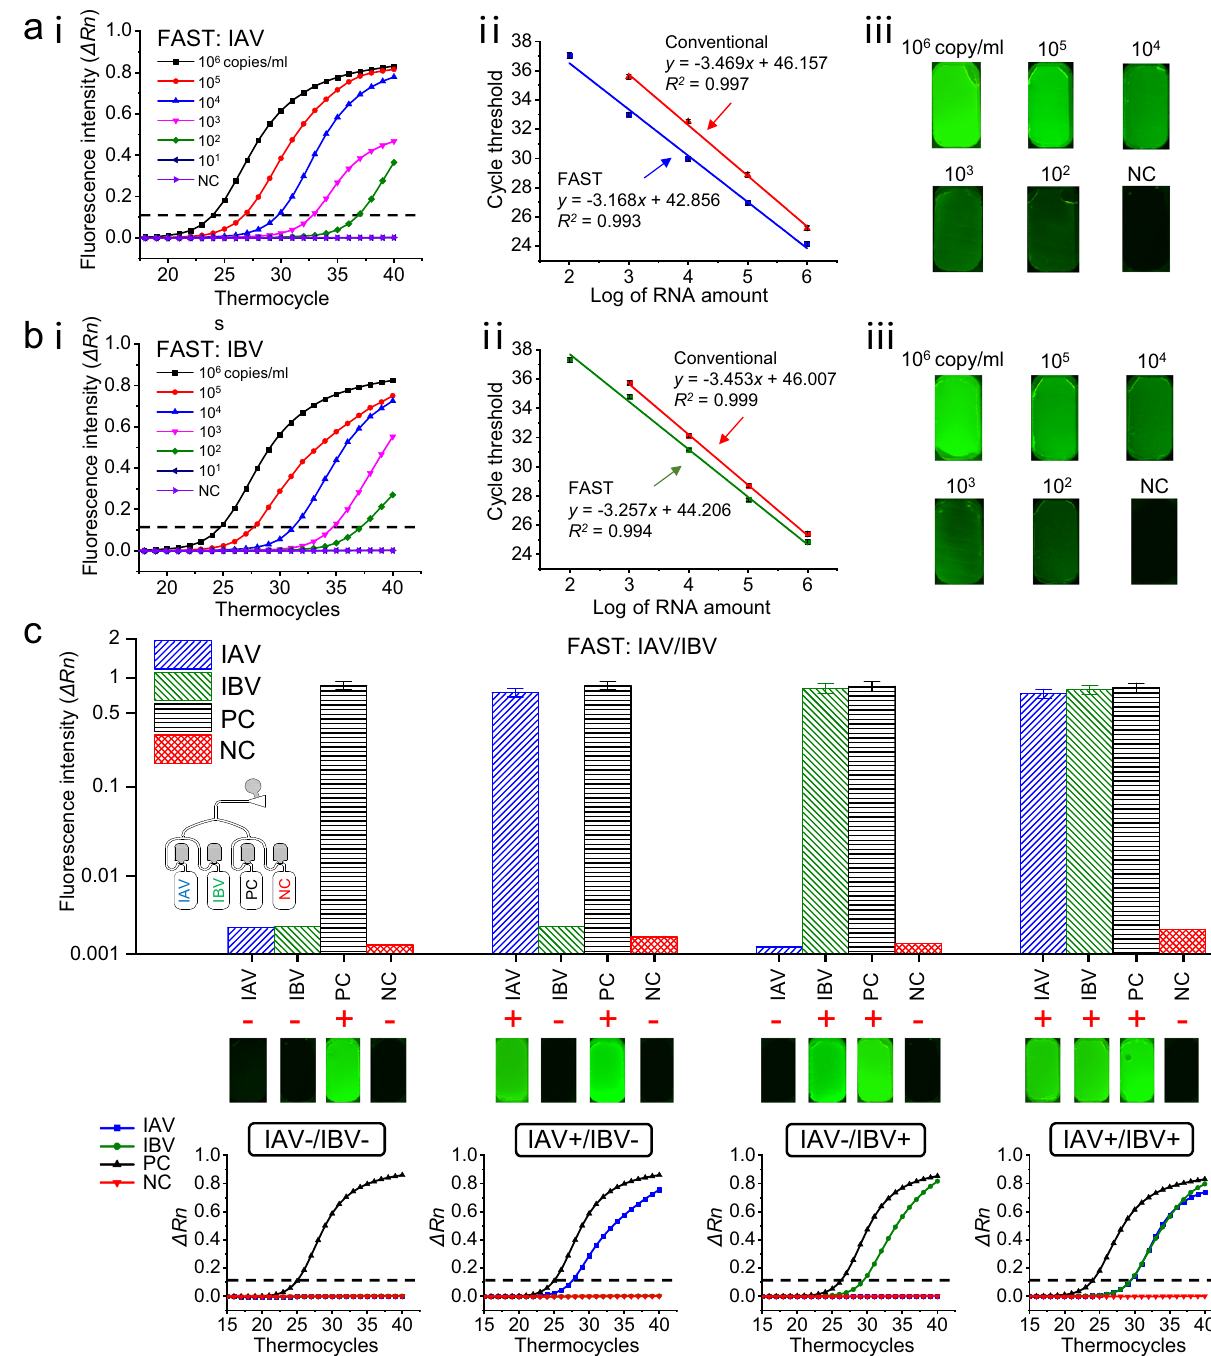
Fig. 5 | PCRtesting resultsfor in fl uenzavirus. a PCRtesting results forin fl uenza A virus (IAV) with IAV concentration ranging from 10 6 to 10 1 copies/ml using TE buffer as the negative control (NC). (i) Real-time fl uorescence pro fi le. (ii) The linear calibration curve between the log concentration of IAV RNA and the cycle threshold (Ct) for both FAST and conventional testing technique. (iii) Fluores- cence images of FAST-POCT with IAV after 40 cycles. b , PCR testing results for in fl uenza B virus (IBV) with (i) real-time fl uorescence pro fi le. (ii) the linear cali- brationcurveand(iii) fl uorescenceimagesofFAST-POCTwithIBVafter40cycles. The lower limit of detection (LOD) for IAV and IBV using FAST-POCT platform is 10 2 copies/ml, which is lower than that of the conventional methods (10 3 copies/